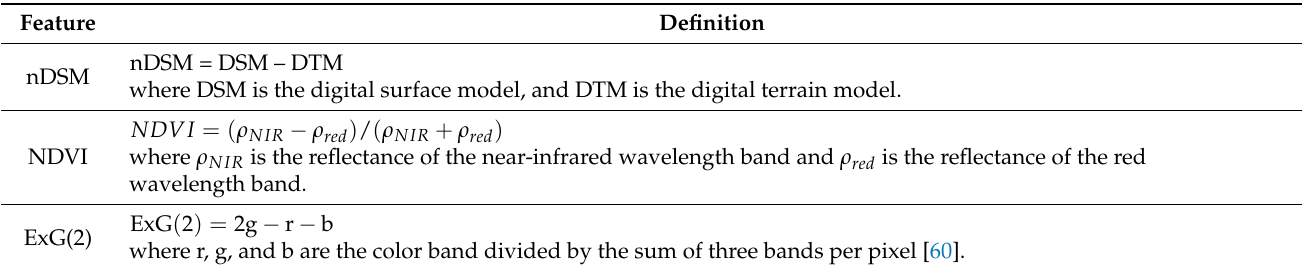
Table 1. Extraction of hand-crafted